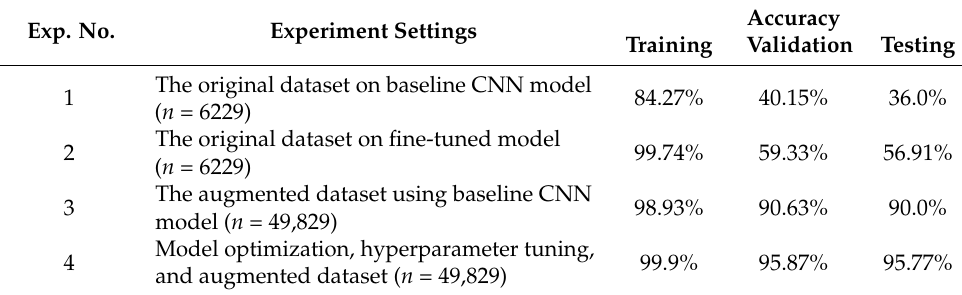
Table 3. Model execution results on different parameters.